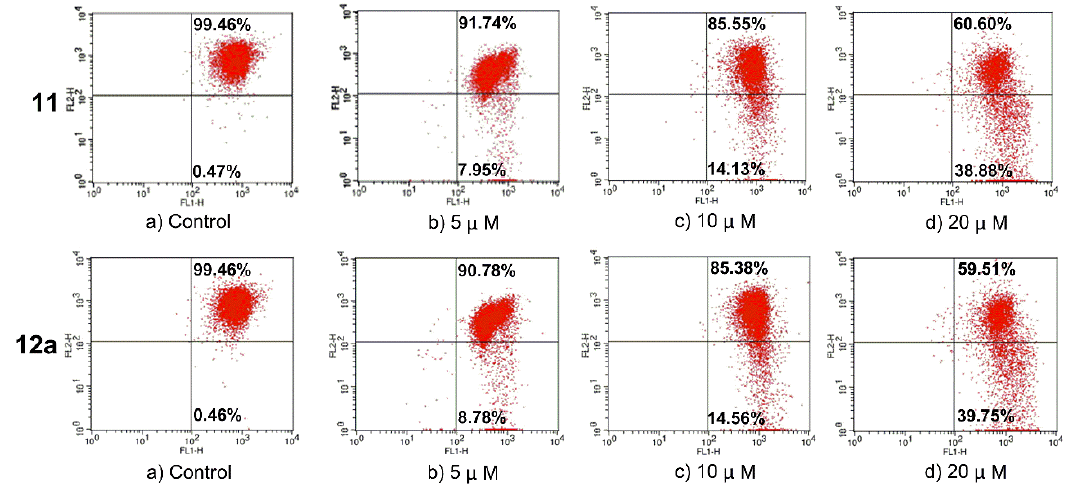
Figure 3. Changes in mitochondrial membrane potential caused by compound 11 / 12a on MCF-7 cells. Incubation with different concentrations of 11 / 12a in MCF-7 cells for 72 h prior to staining with JC-1 dye; the number of cells with collapsed mitochondrial membrane potentials was determined by flow cytometry.